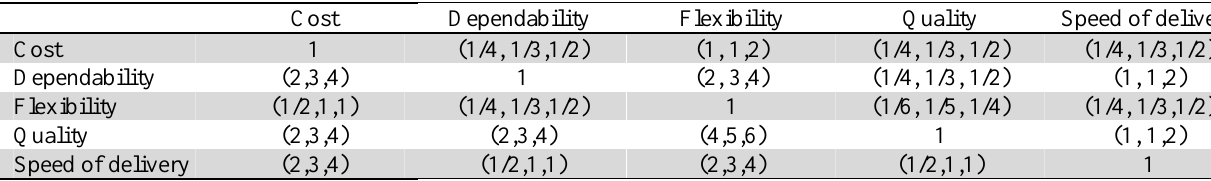
The summary of fuzzy AHP